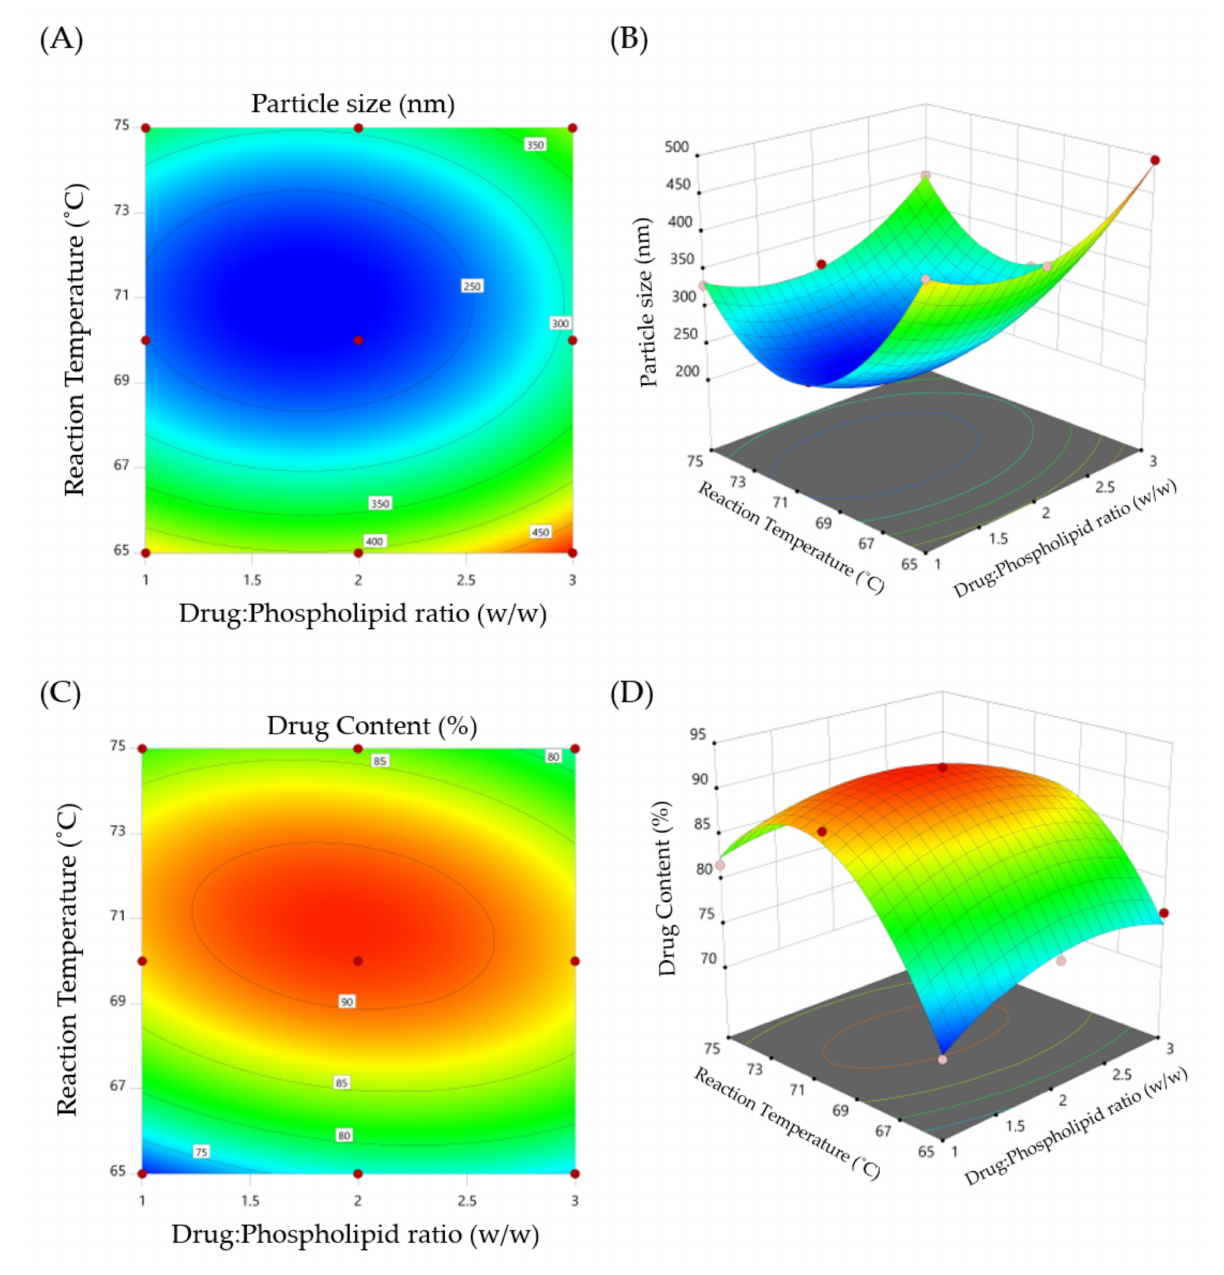
Figure 1. ( A ) Contour plot of particle size (Y 1 ); ( B ) 3D surface plot for Y 1 ; ( C ) contour plot of drug content (Y 2 ); and ( D ) 3D surface plot for Y 2